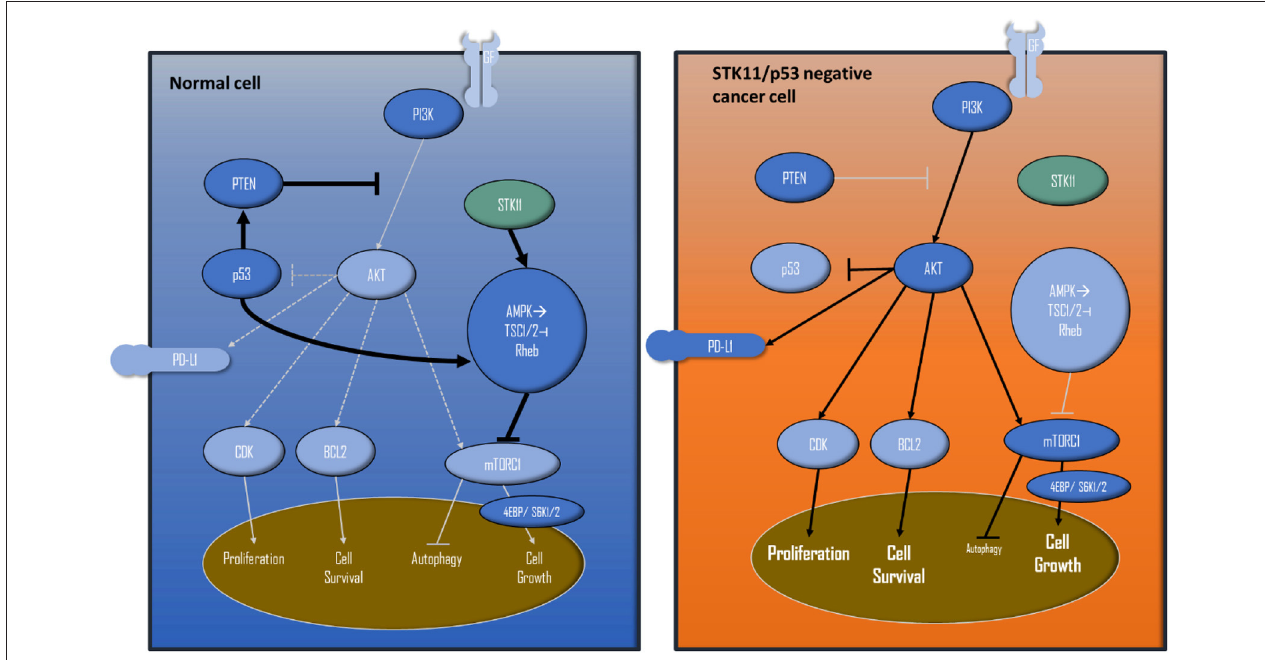
FIGURE 3 | Simplified PIK3/AKT/mTOR pathway and interactions with STK11 and p53. The left shows a wild-type cell, the right cell displays how STK11 and p53 loss of function leads to extensive proliferation/cell survival and cell growth, because of the missing negative feedbacks and activations.